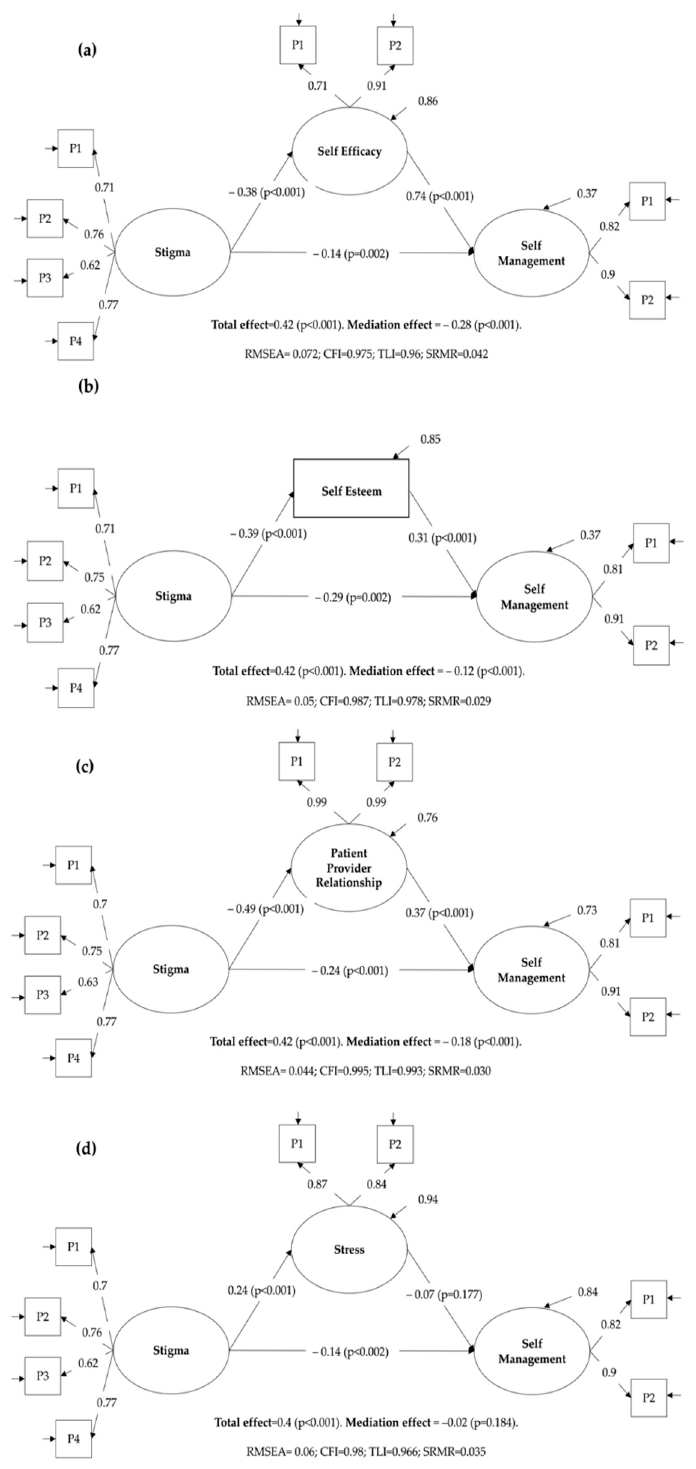
Figure 2. Structural equation models. The panels show different mediation models for the relation- ship between stigma and self-management. The mediators in different panels are: ( a ) self-efficacy, ( b ) self-esteem, ( c ) patient provider relationship, and ( d ) stress. The fit statistics and mediation effect are specified in each panel. P: parcel, RMSEA: Root Mean Square Error of Approximation, CFI: Comparative Fit Index (CFI), TLI: Tucker Lewis Index, and SRMR: Standardized Root Mean Square